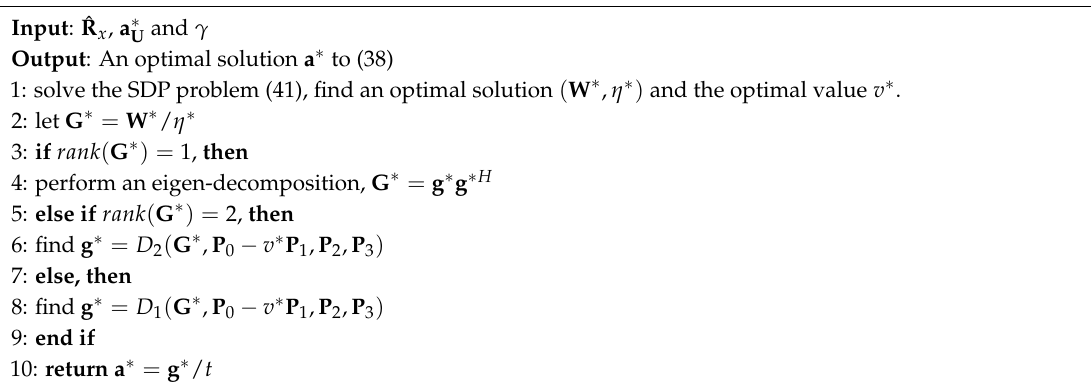
Algorithm 2. Procedure leading to an optimal solution to (38)